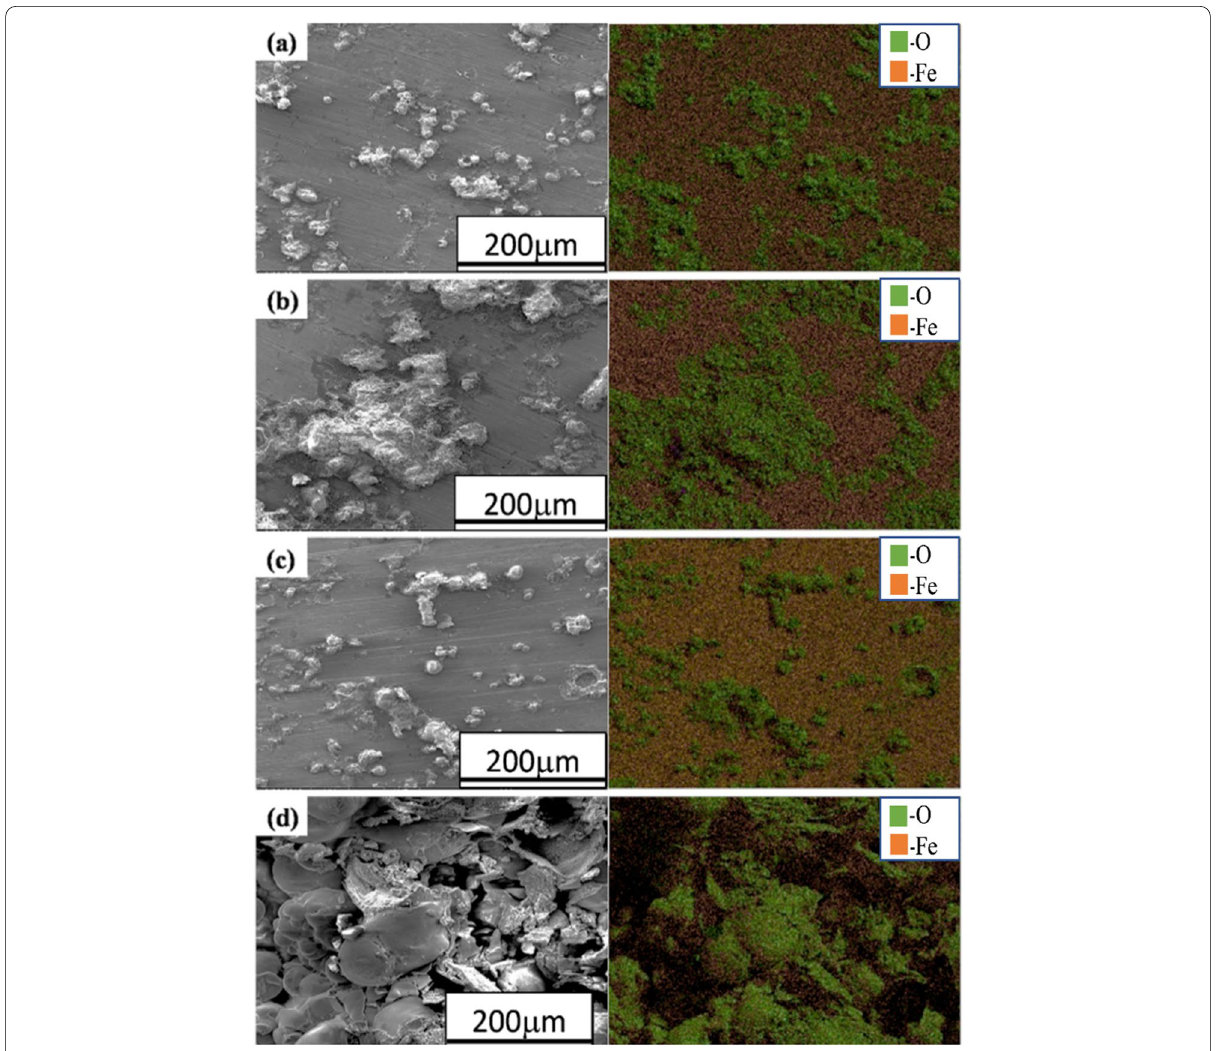
Fig. 11 SEM-EDS elemental maps of the corroded surface of a annealed, b normalized, c quenched, and d austempered AISI 1030 steel specimens after electrochemical testing in 3.5% NaCl